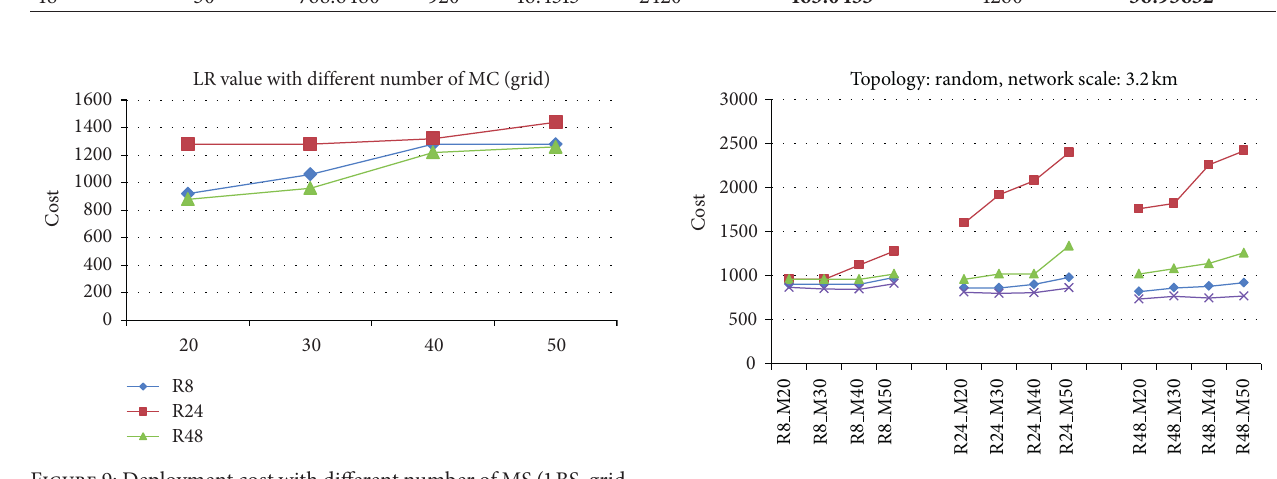
Figure 9: Deployment cost with different number of MS (1BS, grid, 3.2 km).